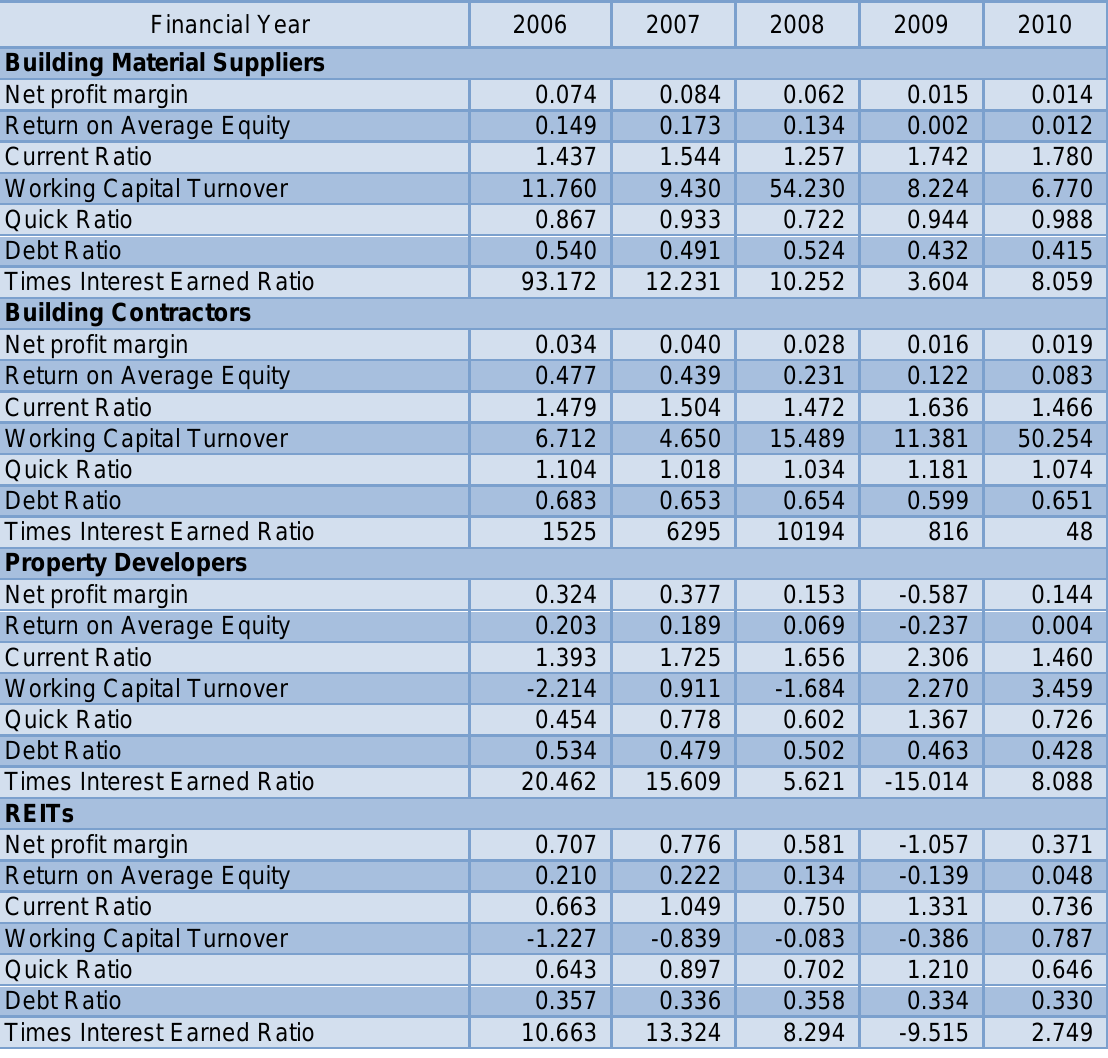
Table 3 Financial ratios (weighted on